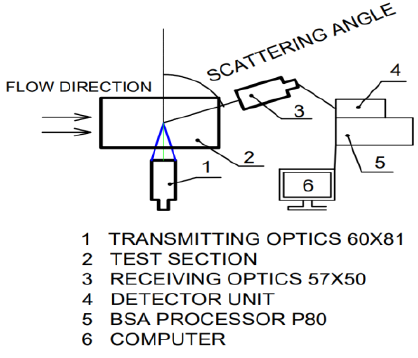
Fig. 2. PDA measurement